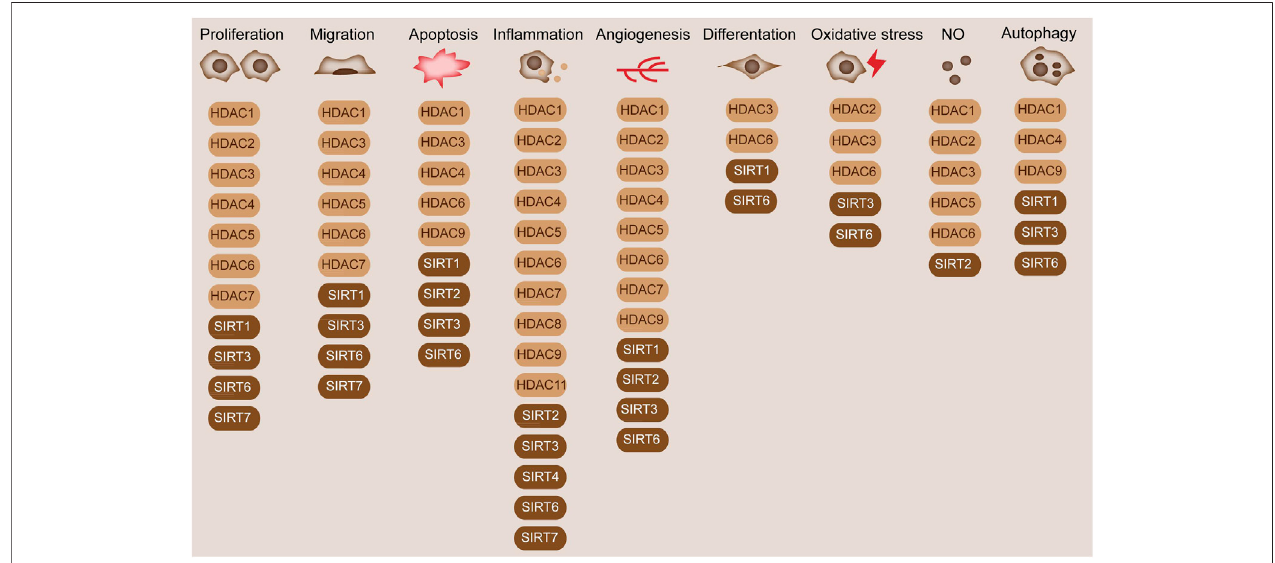
FIGURE3| DiversefunctionsofHDACsinblood vessels.HDACsarewidelyinvolvedinthecellularprocesses inbloodvessels,such ascellproliferation, migration, and differentiation. HDAC1/2/3/4/5/6/7 and SIRT1/3/6/7 are involved in cell proliferation. HDAC1/3/4/5/6/7 and SIRT1/3/6/7 regulate cell migration. HDAC1/3/4/6/9 and SIRT1/2/3/6 mediate cell apoptosis. HDAC1/2/3/4/5/6/7/8/9/11 and SIRT2/3/4/6/7 modulate in fl ammation. HDAC1/2/3/4/5/6/7/9 and SIRT1/2/3/6 modulate angiogenesis. HDAC3/6 and SIRT1/6 modulate cell apoptosis. HDAC2/3/6 and SIRT3/6 are associated with oxidative stress. HDAC1/2/3/5/6 and SIRT2 are associated with NO production. HDAC1/4/9 and SIRT1/3/6 modulate cell autophagy.